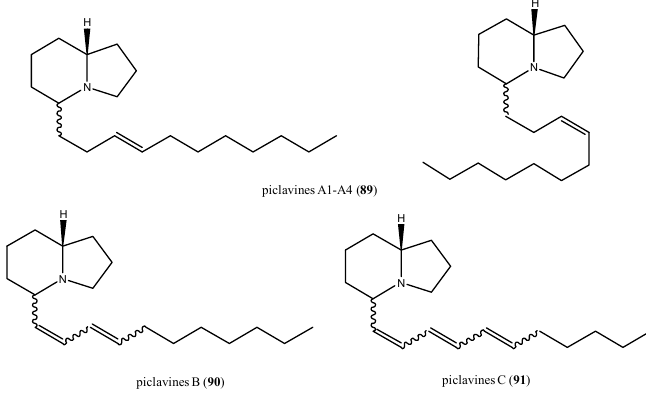
Figure 10. Structures of the indolizine alkaloids piclavines ( 89 – 91 ).